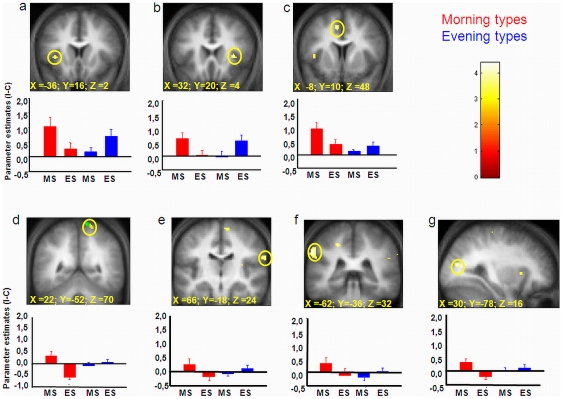
Task-related responses (I vs C) according to time of day (MS: morning session vs. ES: evening session) and chronotype (red: morning types; blue: evening types).Displays show areas (highlighted in yellow) in which activity is associated with a task-related interaction effect between Chronotype and Session [(I vs. C)*(morning vs. evening session)*(morning vs. evening types)]. Corresponding parameter estimates (arbitrary units ± SEM) are displayed. Functional results are displayed at p<0.001, uncorrected threshold, over the mean normalized structural MR image of the population.